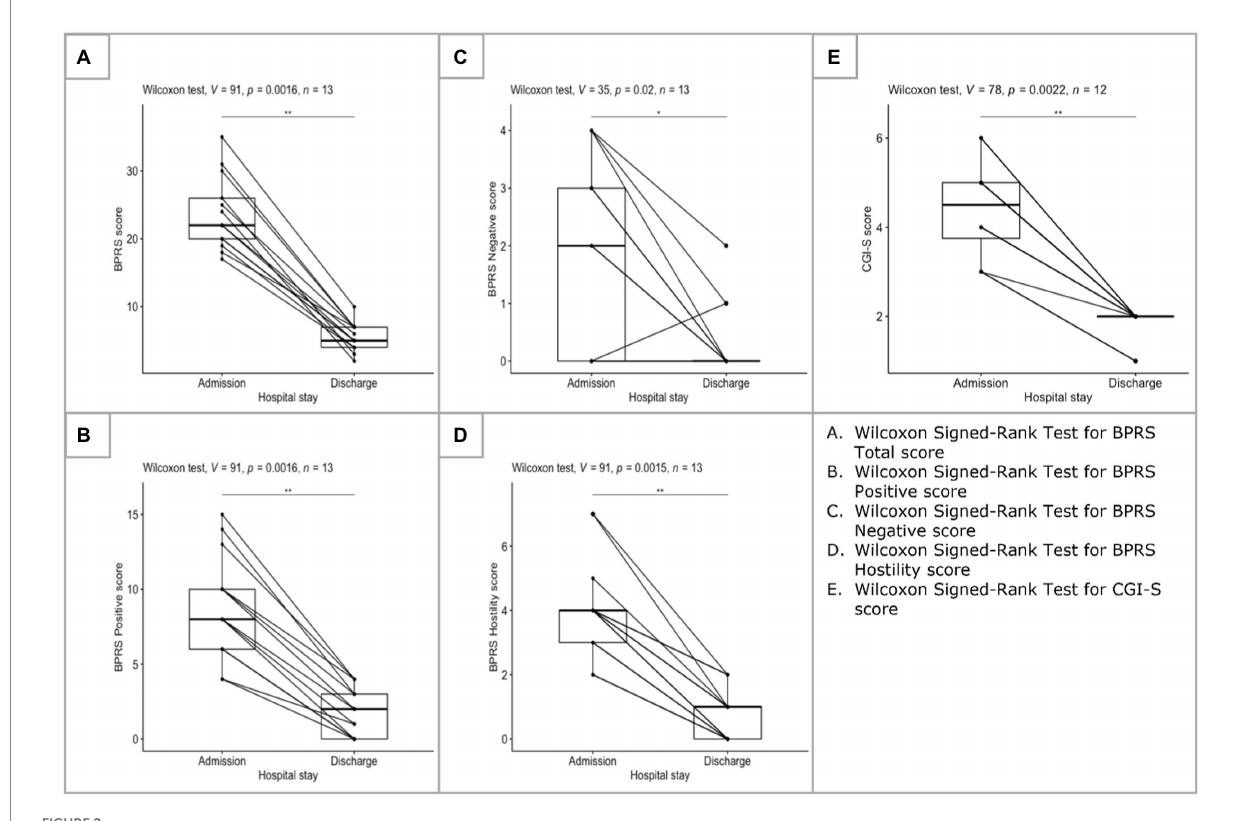
FIGURE 2 Changes between admission and discharge.